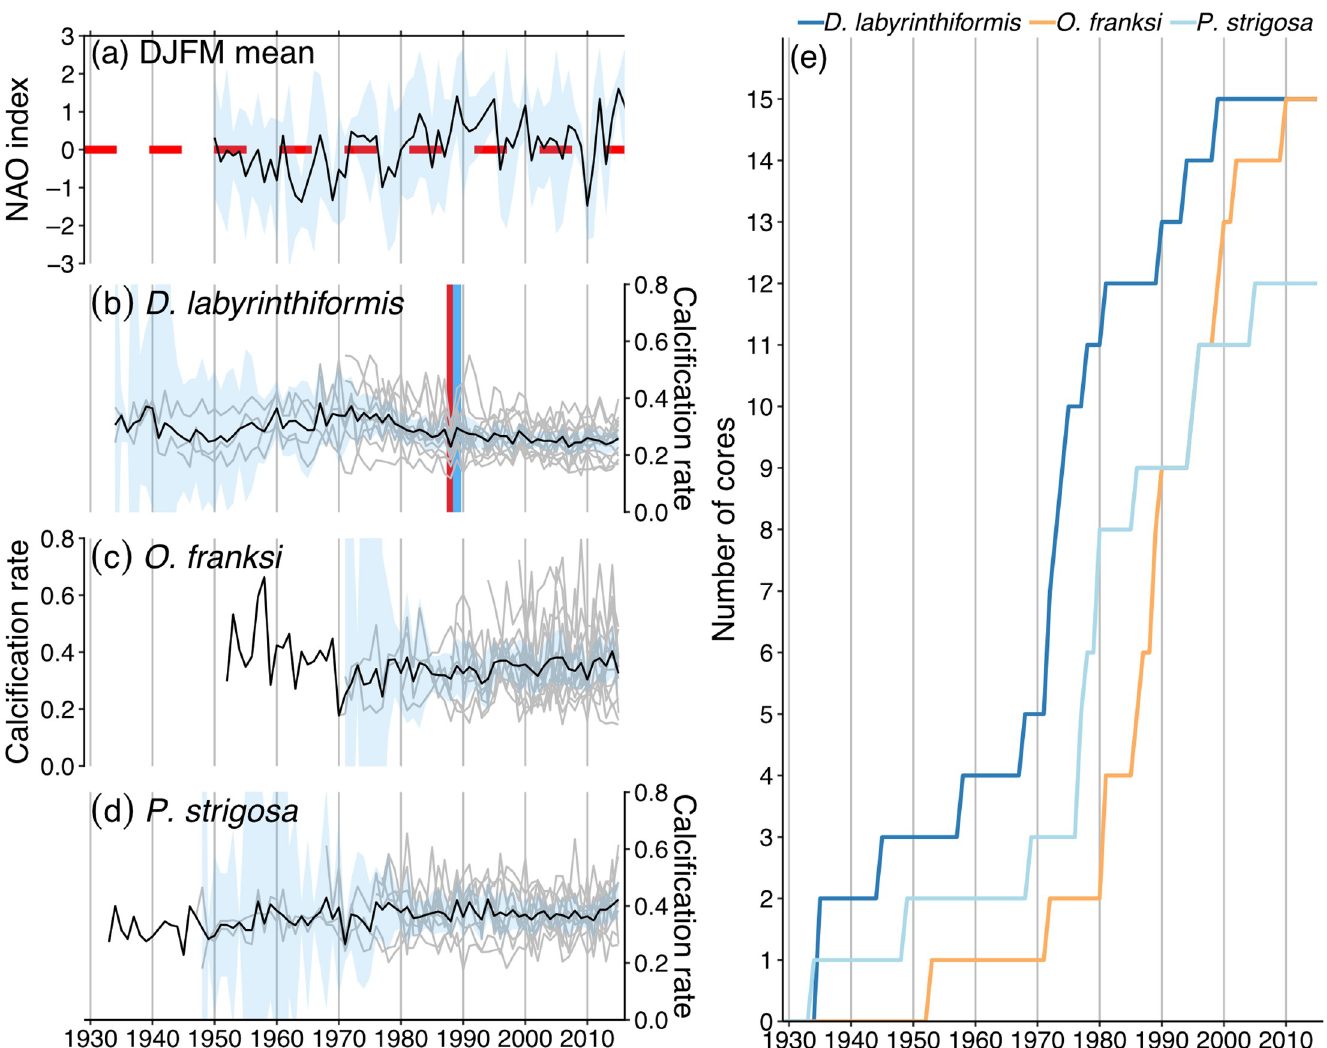
Fig 2. Mean winter NAO index and coral core calcification chronologies. (a) Black line indicates mean of NAO index for DJFM with shaded ± 95% confidence intervals in light blue and dashed-red line indicating zero. (b,c,d) Gray lines indicate calcification rates (g cm –2 yr –1 ) for individual coral cores and the black lines with light blue shading represent mean calcification rates ± 95% confidence intervals for each species. The vertical red line indicates the negative pointer year and the vertical light blue line indicates the positive pointer year. (e) Lines indicate the number of cores with calcification rate data for the respective year from each species.